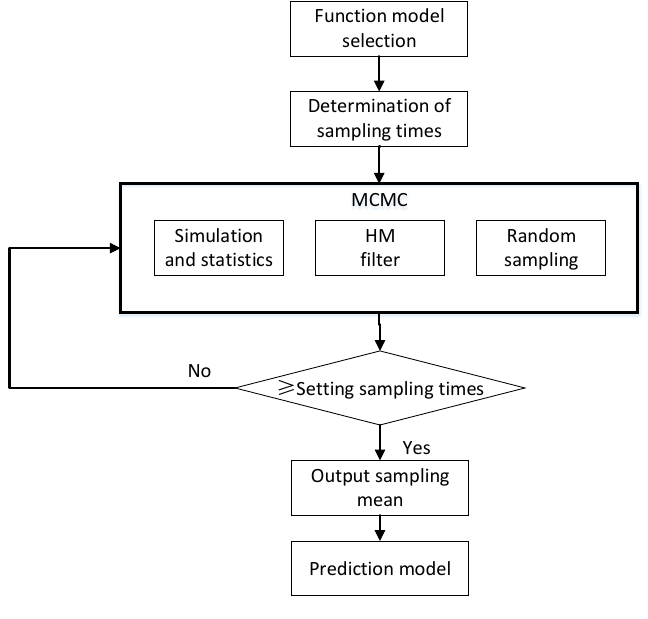
Figure 3. Flowchart of energy use behavior